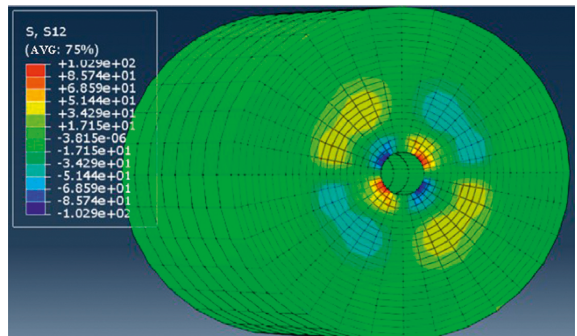
Figure 27: Stress cloud of intermediate layer S12 in 400% com- pression shear condition.